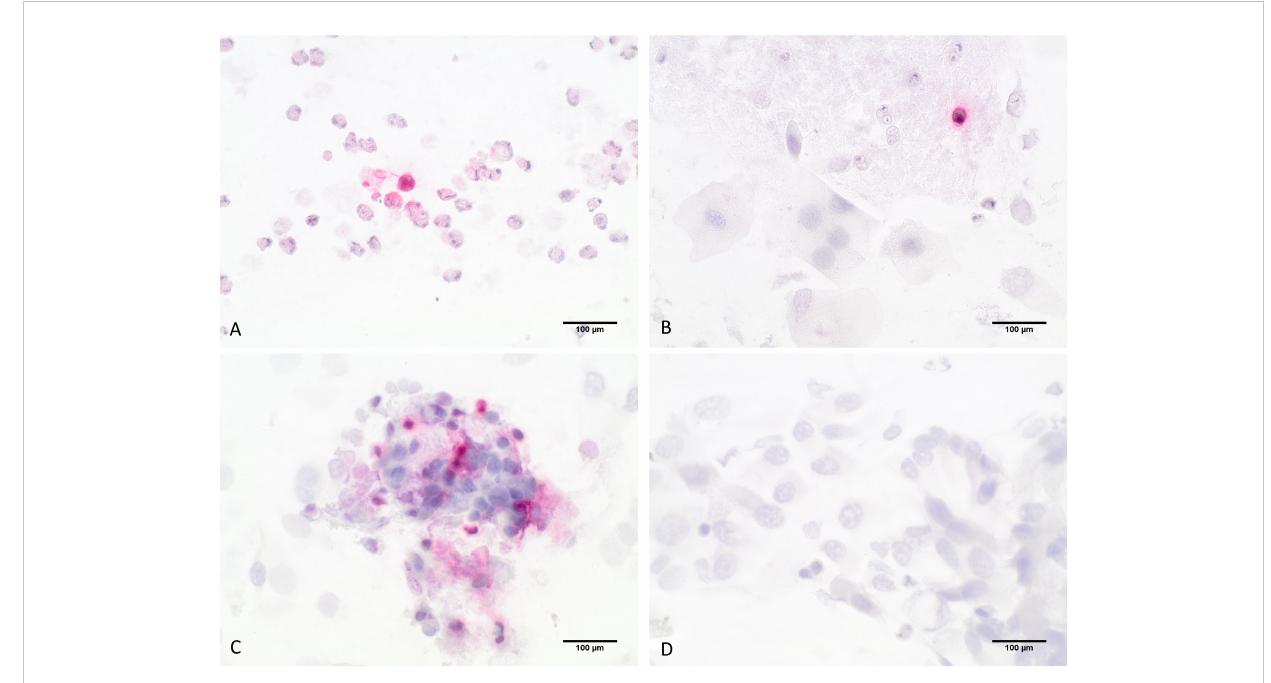
FIGURE 3 Detection of eosinophils by ICC-staining; (A – C) show eosinophilic granulocytes stained in red that were speci fi cally detected by an anti- ribunuclease-3/ECP-antibody, (D) shows the negative control slide; 60-fold magni fi